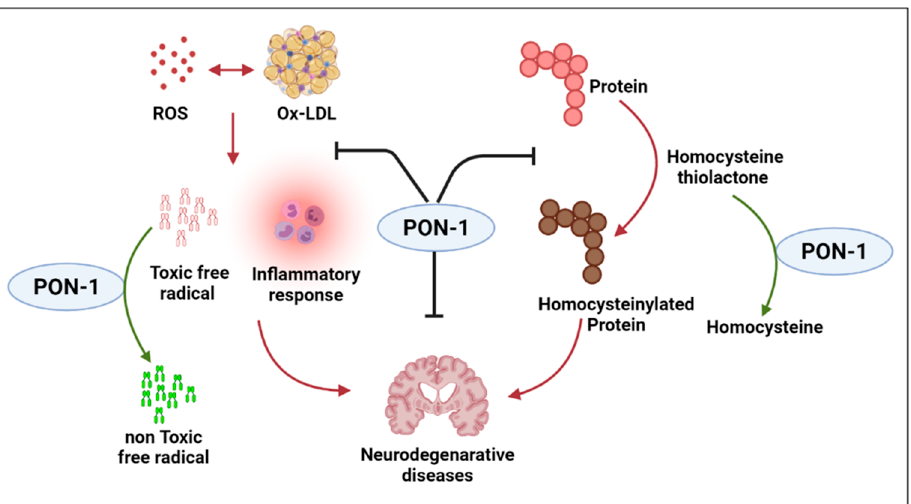
Figure 3. Summary of the mechanistic involvement of PON-1 against susceptibility to Alzheimer’s disease.